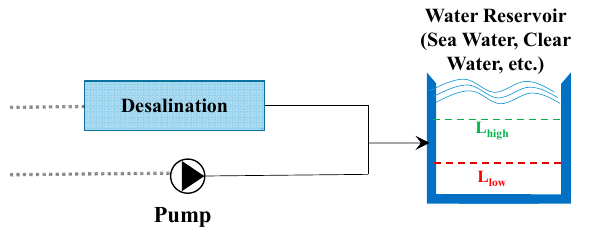
Figure 2. Current operation of the desalination system in Kythnos, according to the High and Low-Level of each Reservoir.